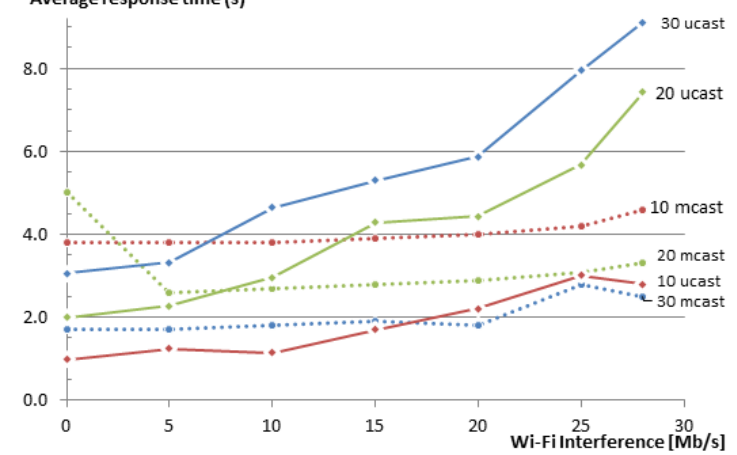
Figure 12. Entity response time for both unicast and multicast group communication and varying group sizes in the presence of Wi-Fi